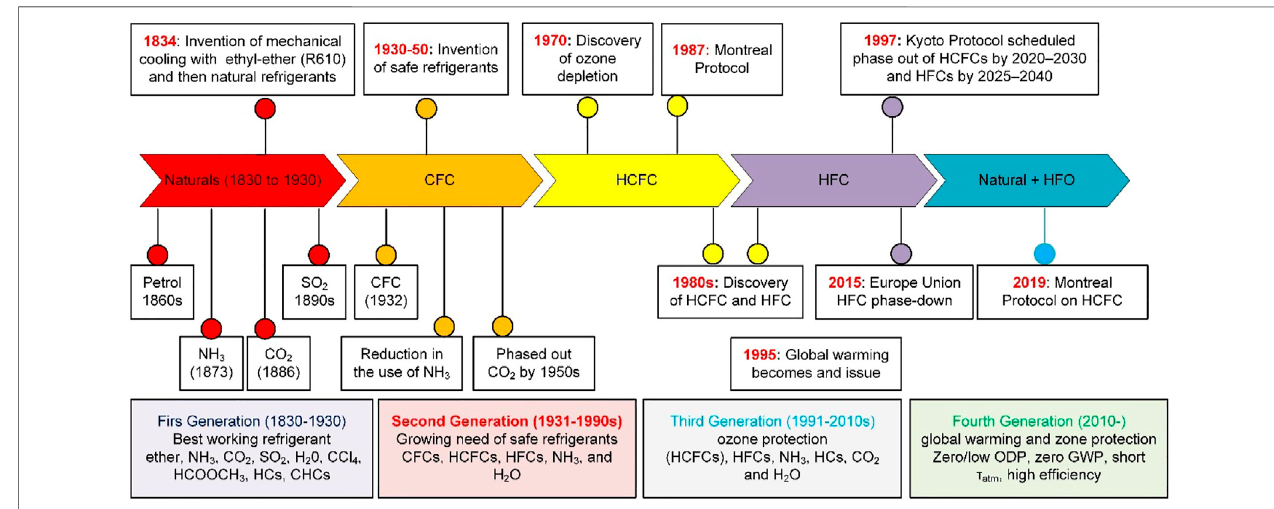
FIGURE 4 | A brief history of refrigerants used in cooling (Dilshad et al., 2020).